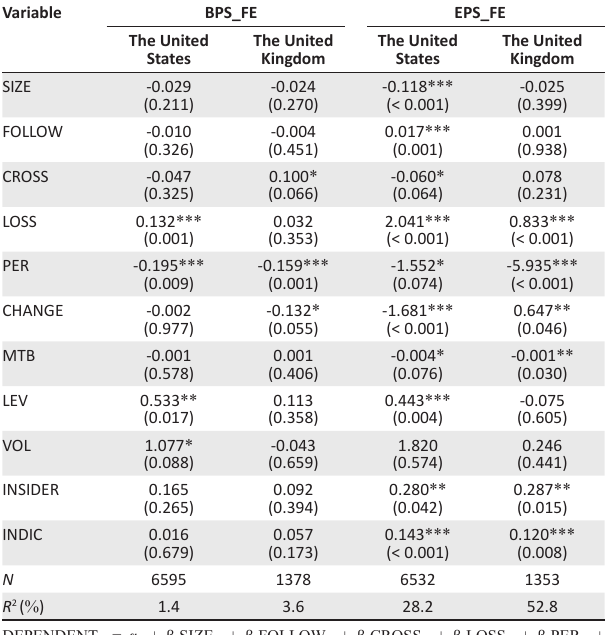
TABLE 5: Regression results using an indicator variable.